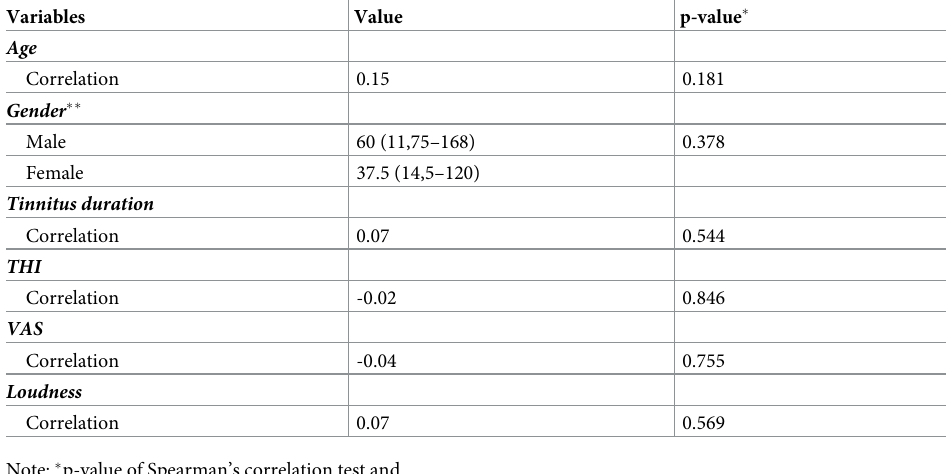
Table 3. Comparison of caffeine consumption in the usual diet across